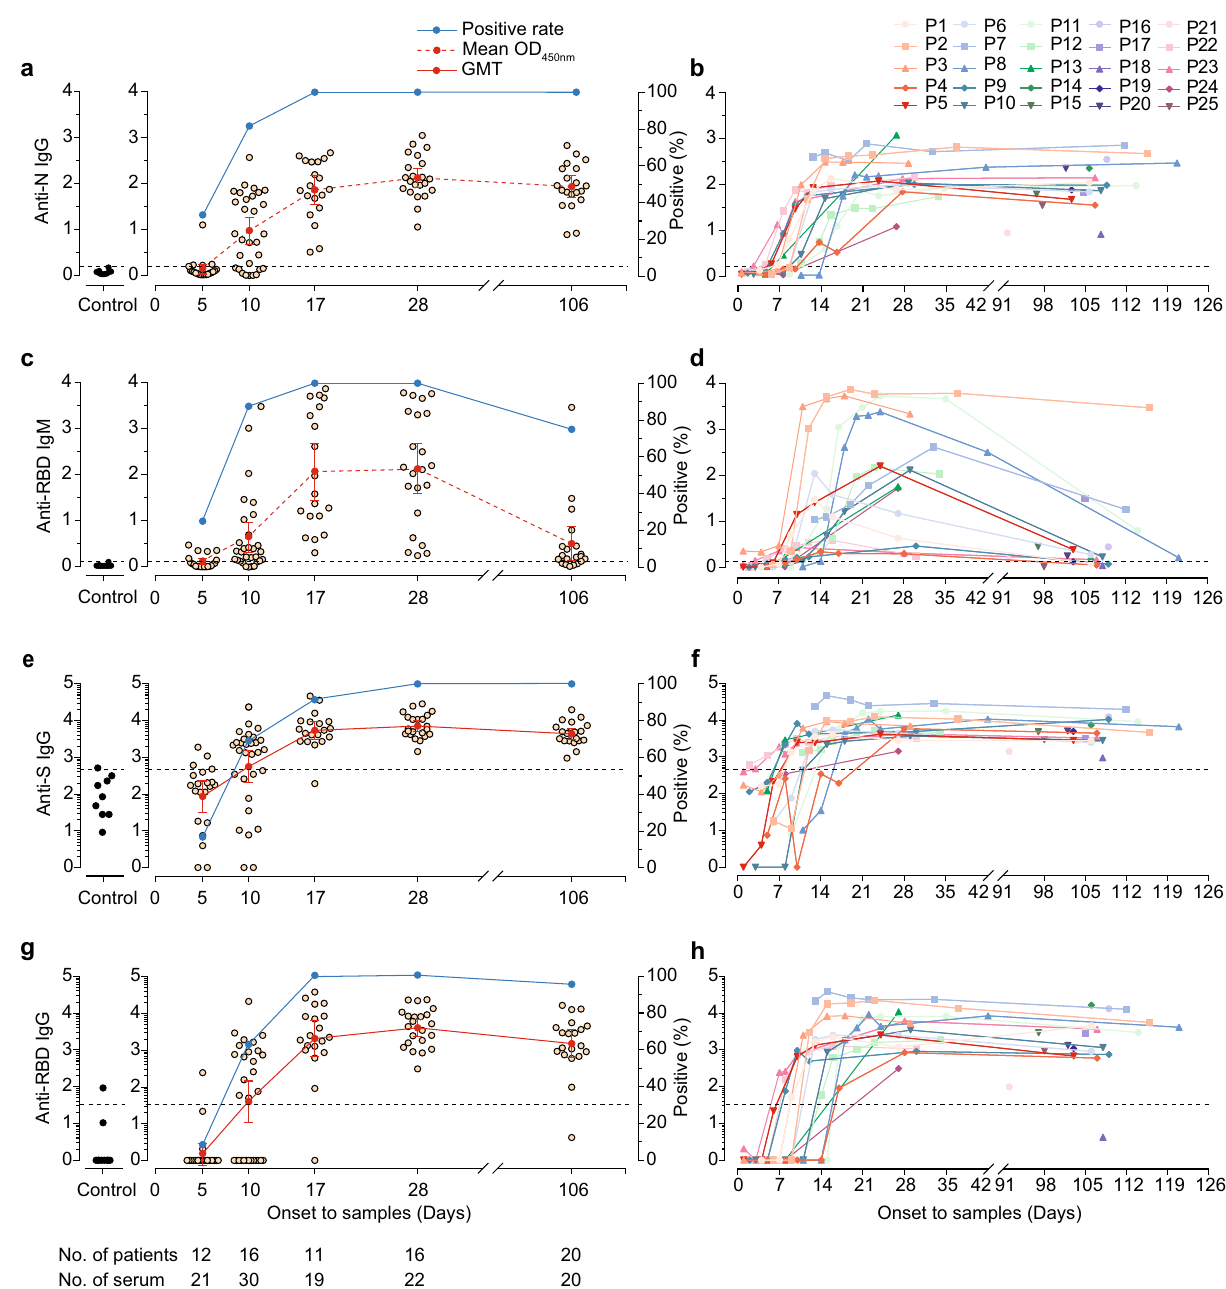
Fig. 1 IgG and IgM antibody response kinetics in the serum of patients with SARS-CoV-2 infection, by days after symptom onset. a – d The percentages (blue line) of patients (P) with serum samples that were positive for IgG to the nucleocapsid (N) protein ( a ), IgM to the receptor-binding domain (RBD) of SARS-CoV-2 spike (S) ( b ), IgG to the S ( c ) and RBD ( d ), and the corresponding mean optical density (OD) for anti-N IgG and anti-RBD IgM and log 10 - transformed geometric mean endpoint titer (GMT) for anti-S and -RBD IgG (red dashed line). Error bars represent the 95% con fi dence interval. Each circle represents the titer for a serum sample. e – h Individual level for anti-N IgG ( e ), anti-RBD IgM ( f ), anti-S IgG ( g ), and anti-RBD IgG ( g ) in serum samples collected from patients, and the samples from the same patients are connected by the lines. Black dashed line indicates the threshold for positivity (anti-N IgG = 0.19, anti-S IgG = 439.5, anti-RBD IgG = 33.2, and anti-RBD IgM = 0.105). Source data included as a Source Data p < 0.0001), and anti-RBD IgG (Spearman r = 0.707, p < 0.0001) patients still had high NAb titre of ≥ 1:640 3 – 4 months PSO, (Fig. 2c). Anti-RBD IgM antibodies were also correlated with NAb whereas we observed relatively low NAb titre ( ≤ 1:80) for titre (Spearman r = 0.714, p < 0.0001). We additionally observed a strong correlation between anti-S IgG and anti-RBD IgG anti- asymptomatic individual (patient 25, a 3-year-old boy). We bodies (Fig. 2c; Spearman r = 0.908, p < 0.0001). These fi ndings detected no NAb in the serum from healthy controls. We observed suggest that patients produced robust NAb responses after SARS- a signi fi cant correlation between NAb titre and anti-N IgG CoV-2 infection, and that the majority of patients ’ NAb titre (Spearman r = 0.672, p < 0.0001), anti-S IgG (Spearman r = 0.668, persisted 3 – 4 months PSO.